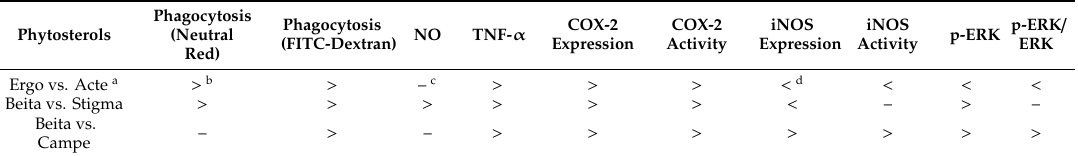
Comparison of anti-inflammatory e ff ects between phytosterols with di ff erent structure. FITC—fluorescein isothiocyanate; NO—nitric oxide; TNF- α —tumor necrosis factor- α